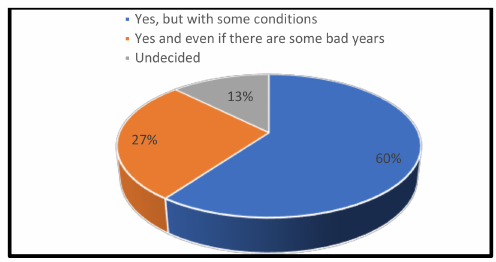
Figure 24. Willingness to produce seeds in large